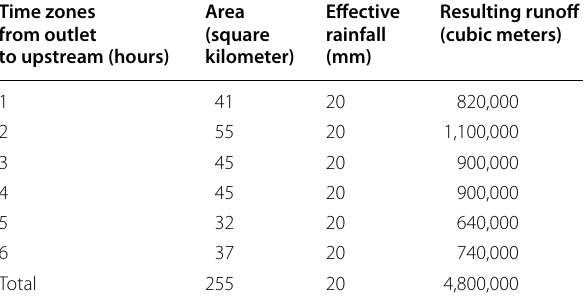
Table 2 Calculation of effective rainfall, resulting runoff, and time zones from outlet to upstream